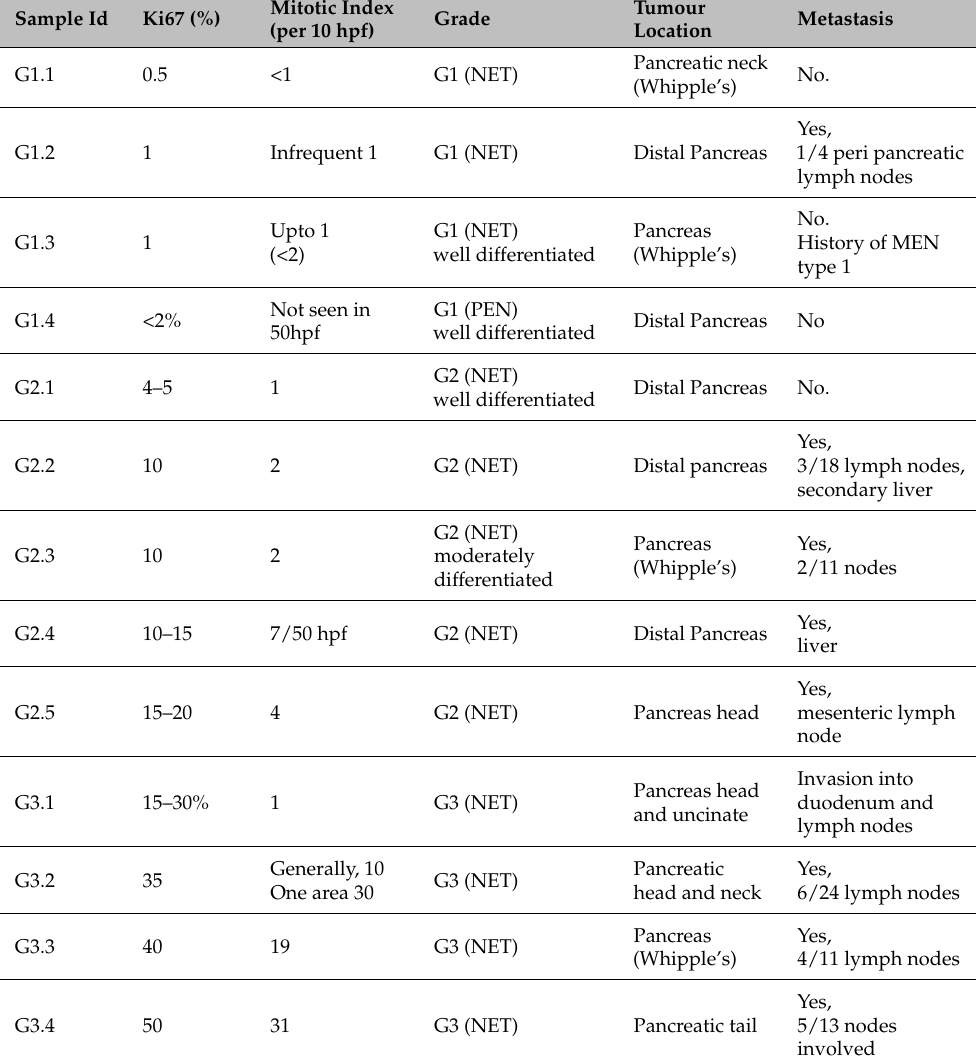
Table 3. Samples and their pathological report detailing Ki67%, grade, tumour location and metastatic